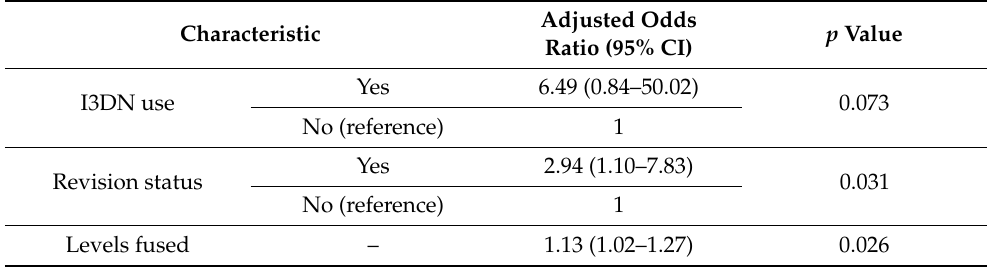
Table 4. Factors associated with return to OR for I&D on multivariable logistic